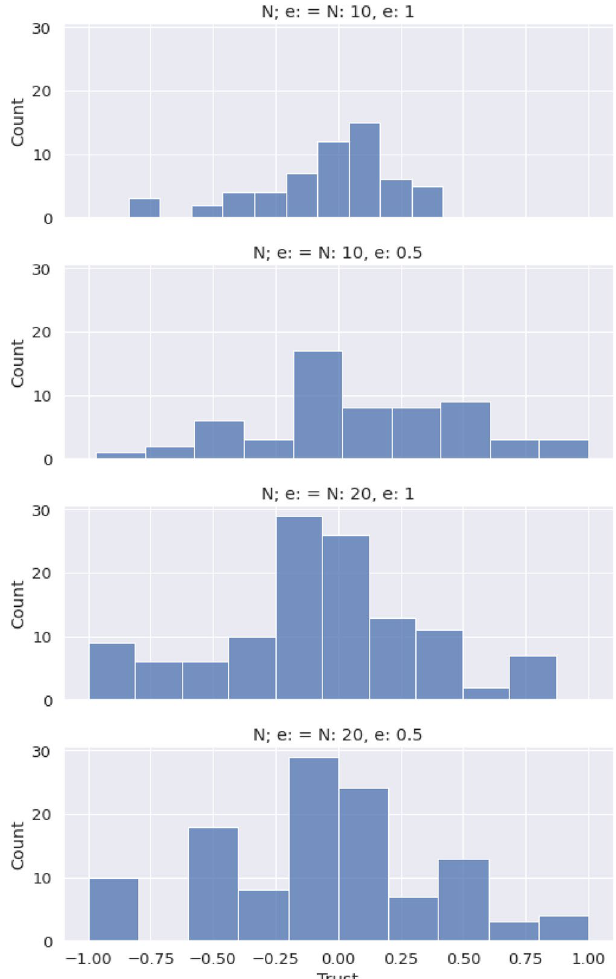
Figure 9. Experimental profiles of trust distributions for the four different configurations, depending on the parameters N,e